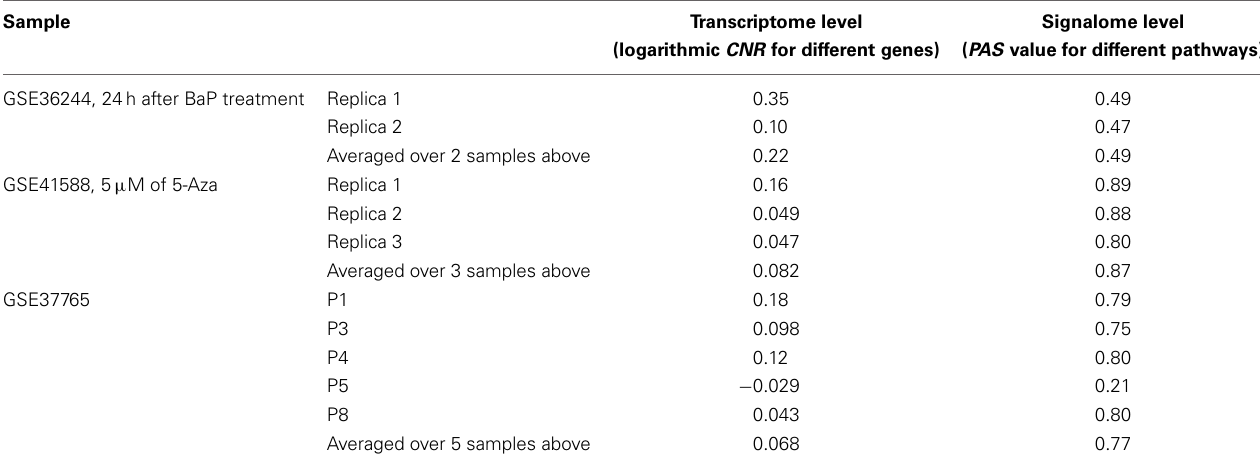
Table 2 | Correlation coefficients between values obtained using the RNA microarray analysis and RNA sequencing methods for the HepG2 cells dataset GSE36244 (van Delft et al., 2012), HT-29 cells dataset GSE41588 (Xu et al., 2013), and lung adenocarcinoma dataset GSE37765 (Kim et al.,